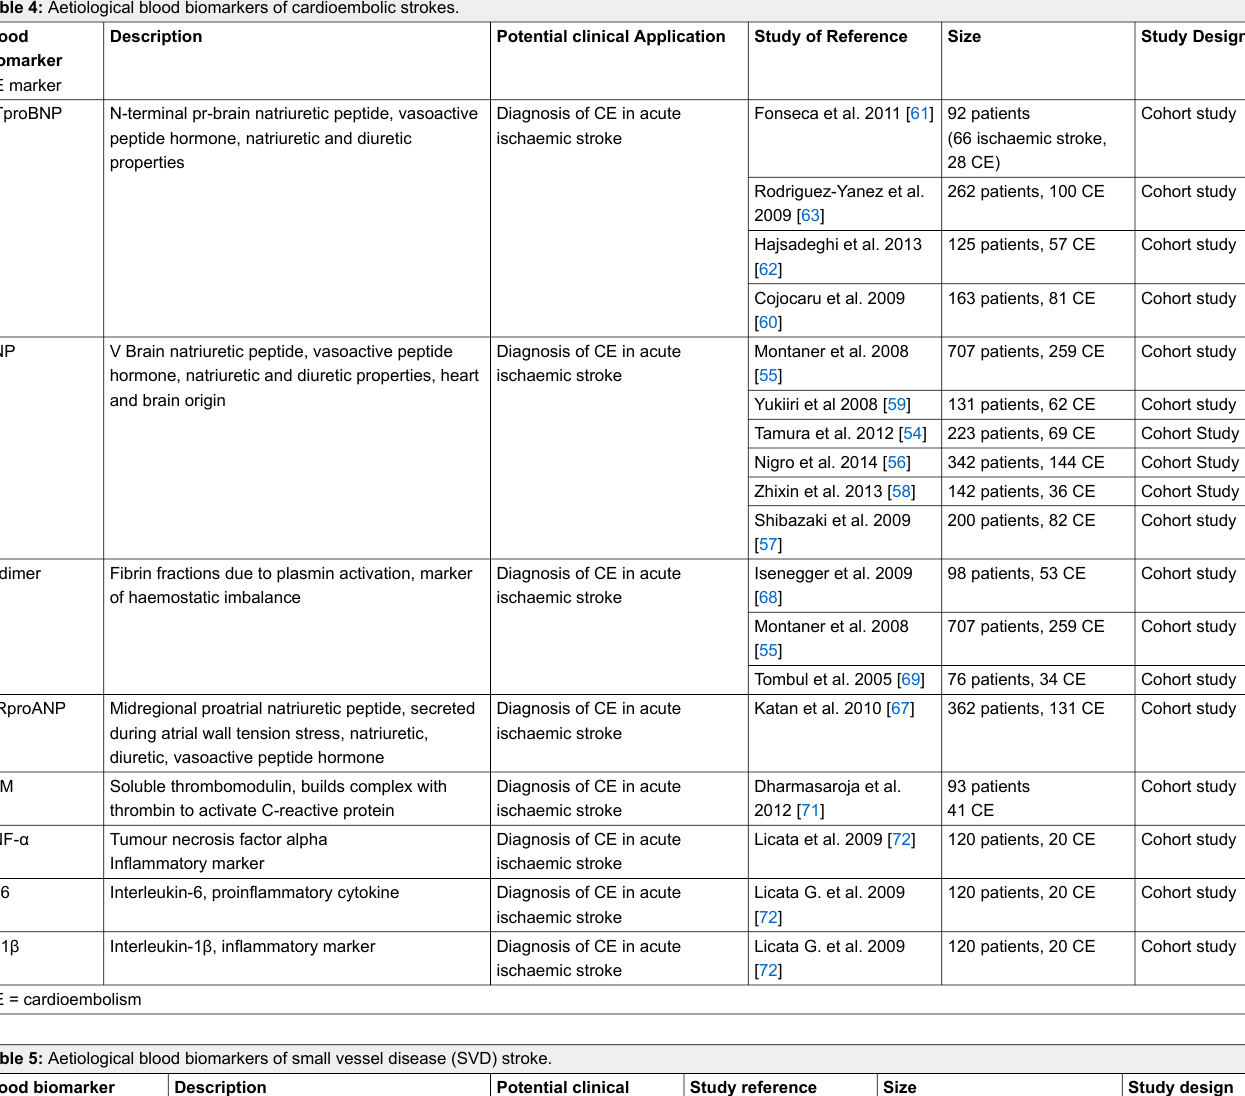
Table 4: Aetiological blood biomarkers of cardioembolic strokes. Blood biomarker